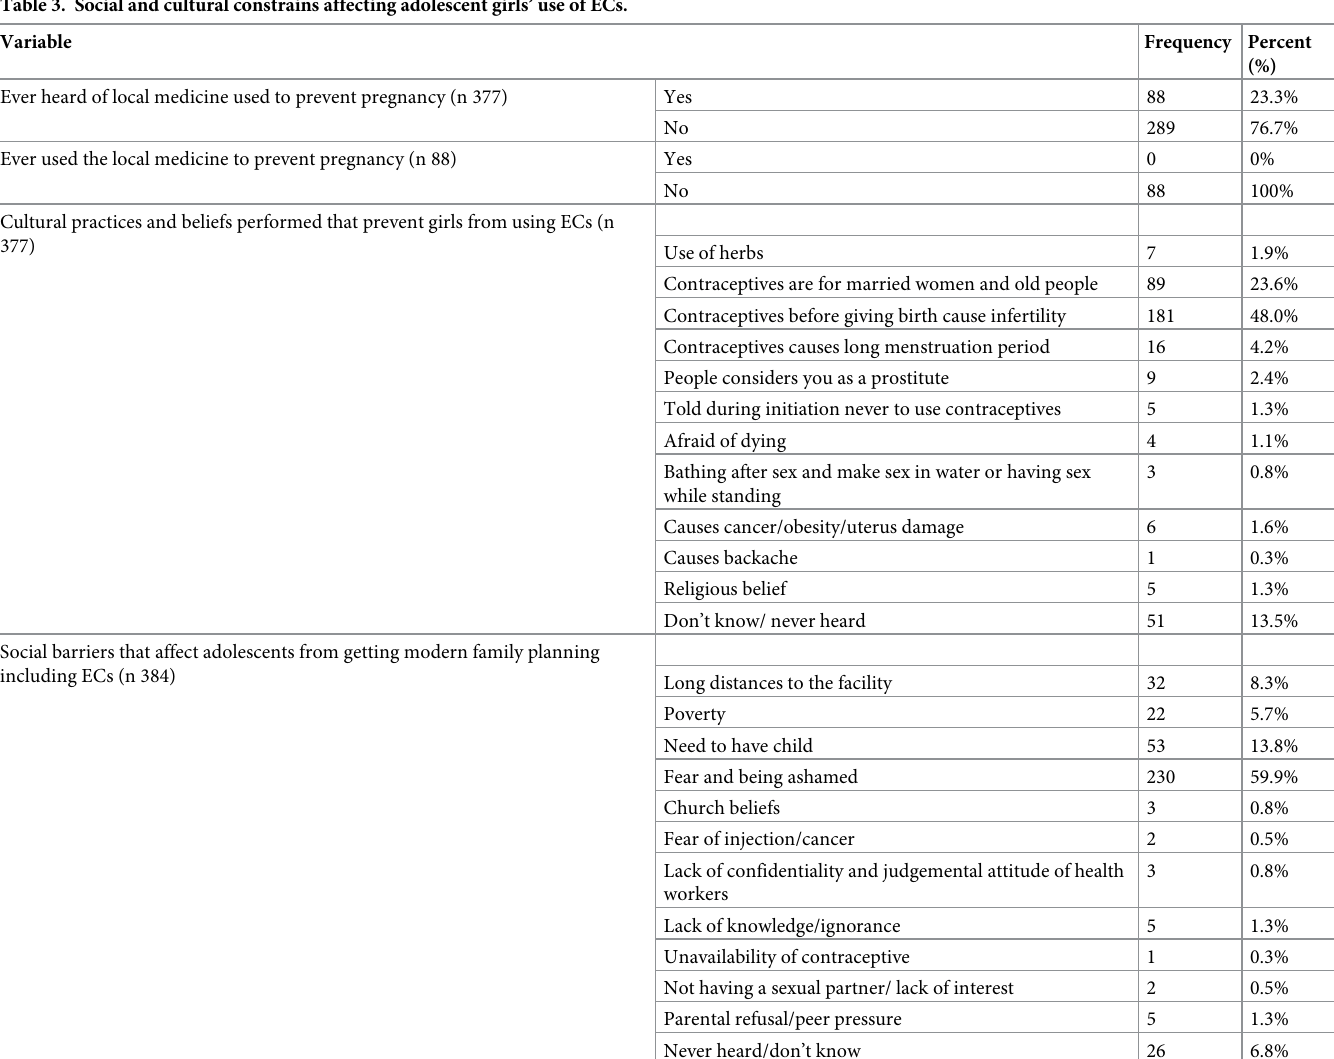
Table 3. Social and cultural constrains affecting adolescent girls’ use of ECs.